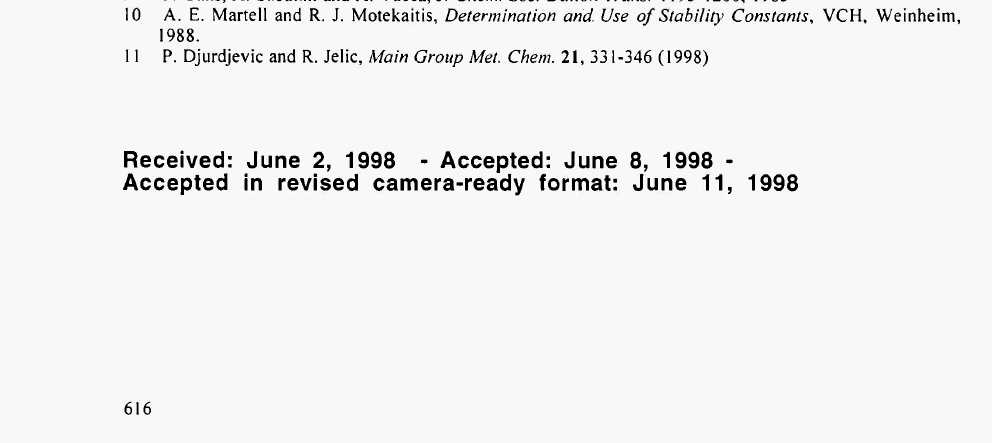
-Ιοβ(Η) Figure 3. Distribution diagram of Al-oßo complexes in 0.1 mol/dm LiCl medium at 298 Κ in the presence of 10.0 mmol/dm sodium dodecylsulphate. [Al] = 2.5 mmol/dm 3 ; [oßo] = 5.0 mmol/dm